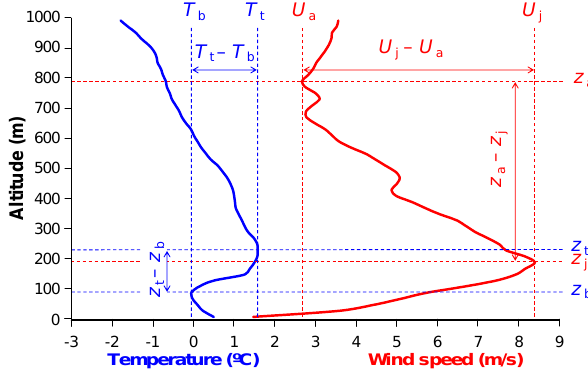
Fig. 3. Example of a tethersonde sounding at 13:00UTC on 10 Au- gust 2007. The variables plotted are wind speed and temperature, provided as an illustration of the definitions